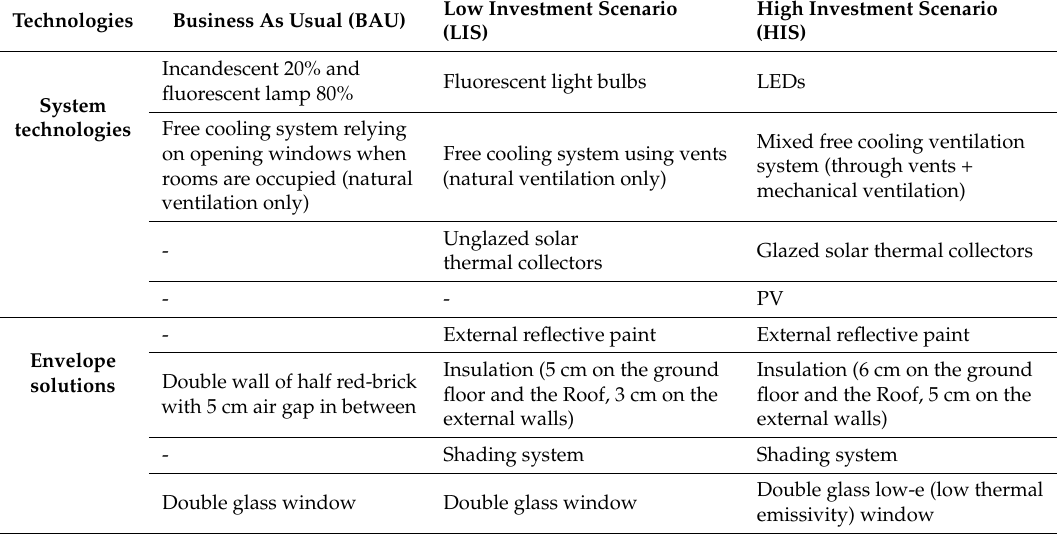
Table 3. List of technologies selected by local stakeholders, authorities, energy market key player